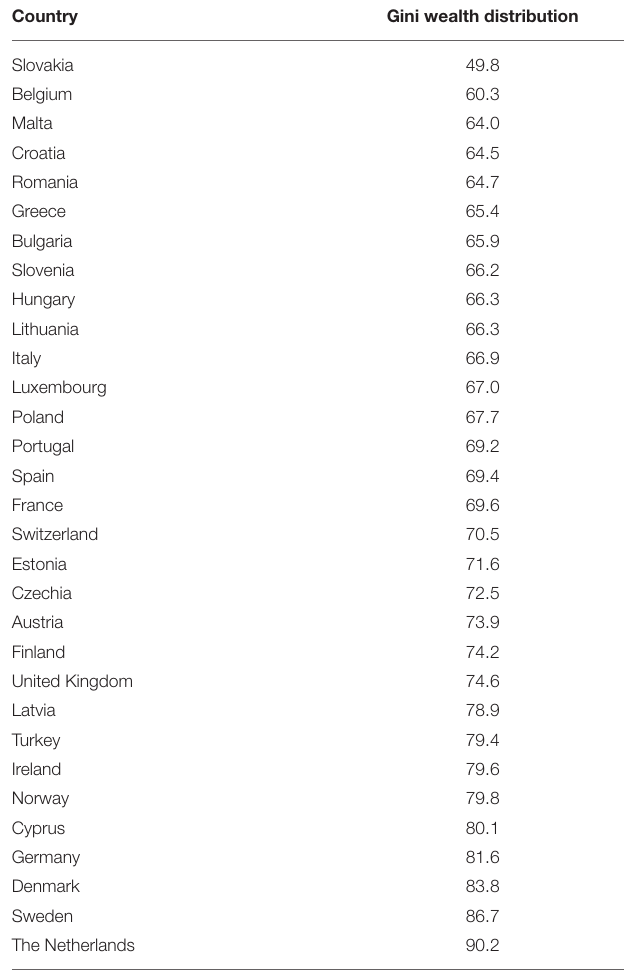
TABLE 2 | Gini coefficient of wealth